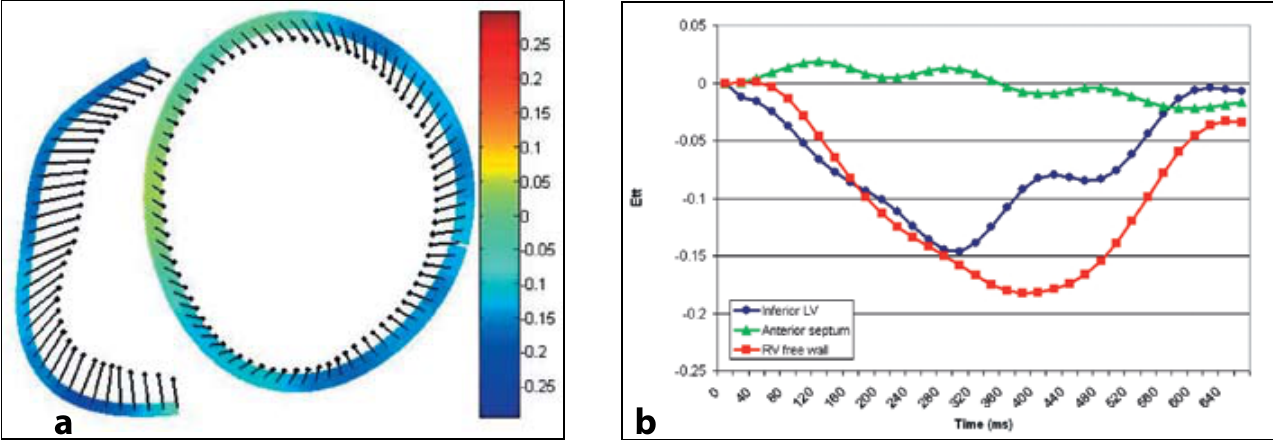
Fig. 10a. Mid-ventricular short-axis map of end-systolic tangential strain of a patient with a right bundle branch block (RBBB) and an anteroseptal infarct (arrows), and (10b) corresponding strain versus time